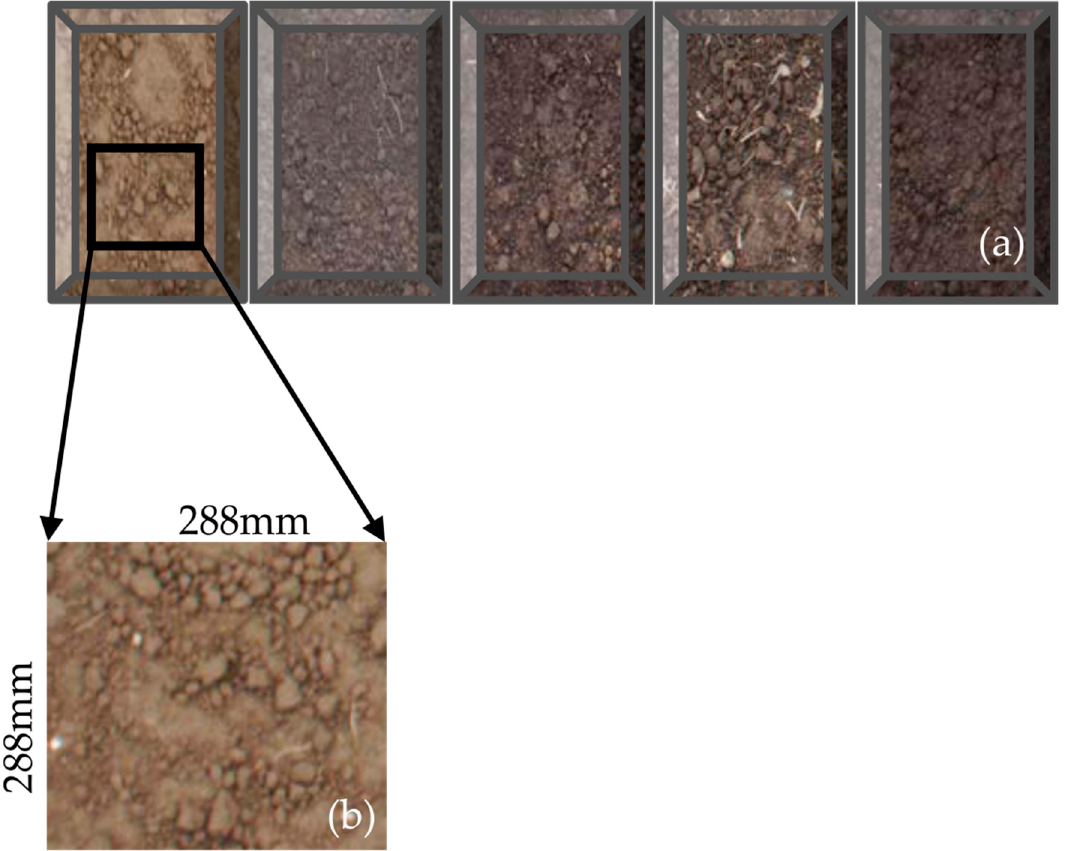
Figure 1. Example of an image selected for analysis: the soil trays photographed on 15 November 2014 ( a ); and one of the five 288 × 288 mm 2 image subset with a pixel size 1.8 mm ( b ).